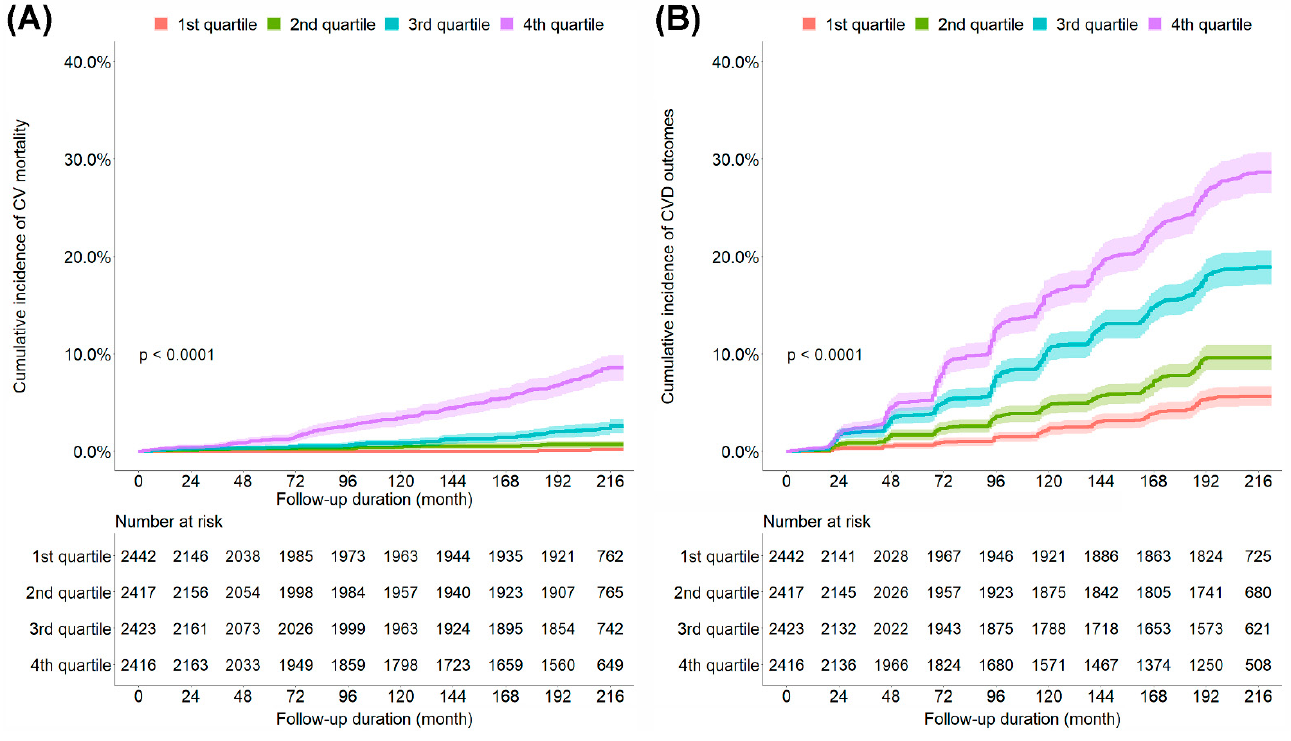
Figure 1. Kaplan–Meier curves comparing the cumulative incidence of CV mortality ( A ) and CVD outcomes ( B ). CV, cardiovascular; CVD, cardiovascular disease; 1st quartile, first quartile of the ePWV; 2nd quartile, second quartile of the ePWV; 3rd quartile, third quartile of the ePWV; 4th quartile, fourth quartile of the ePWV; ePWV, estimated pulse wave velocity. Table 2. Hazard ratios for cardiovascular mortality and cardiovascular disease outcomes according to the quartiles of the estimated pulse wave